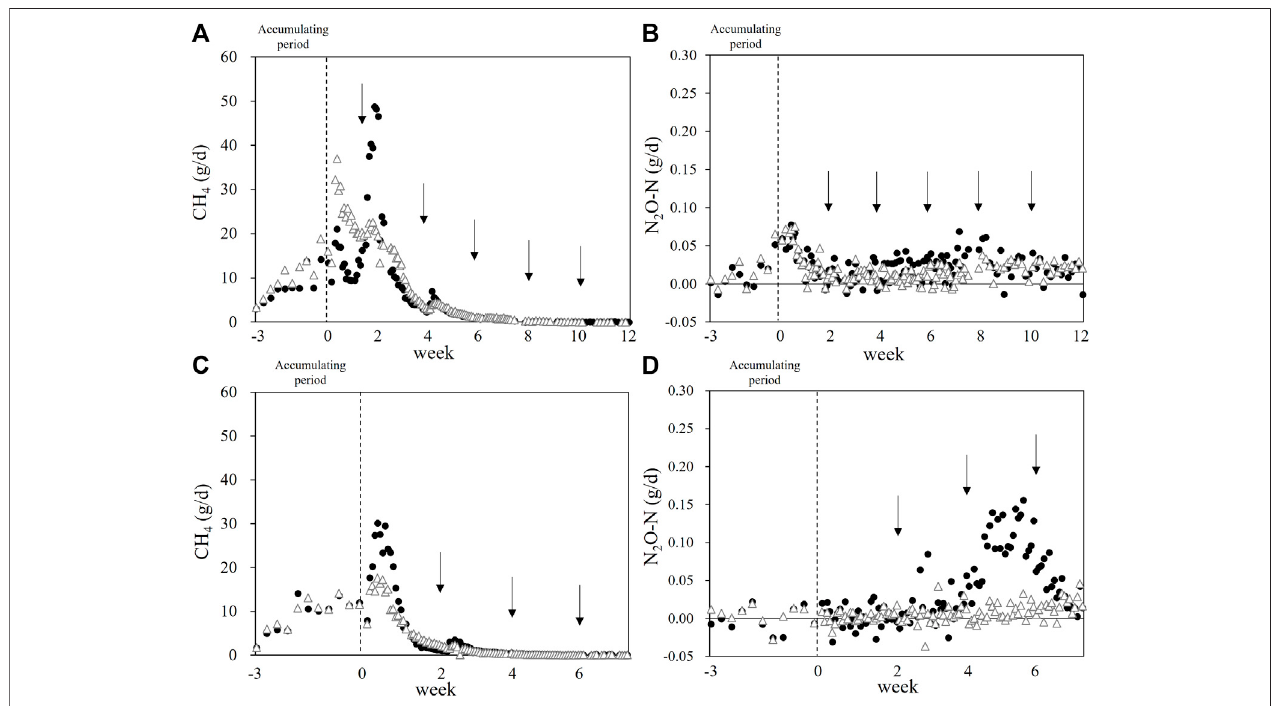
FIGURE 1 | Methane and N 2 O emission during the beef cattle manure storage. Black circles: Control heap. White triangles: Rice straw-mixed heap. Arrows: The mixings for the sampling to monitor manure microbiome. (A , B) : Run 1. (C , D) : Run 2. Dashed lines: The end of the manure accumulation period.